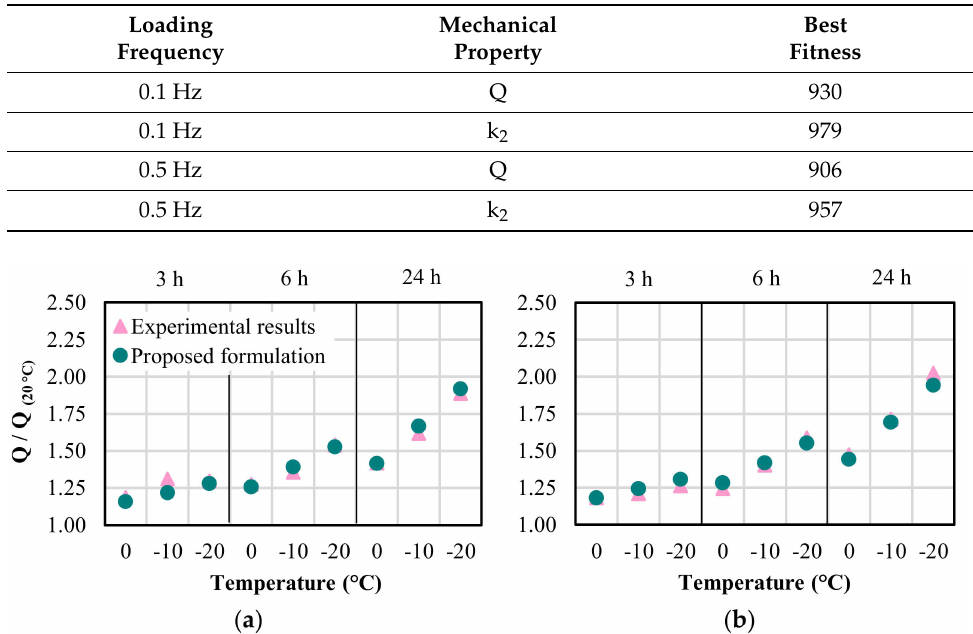
Figure 19. Comparison of experimental amplifications in Q with the proposed formulation estima-